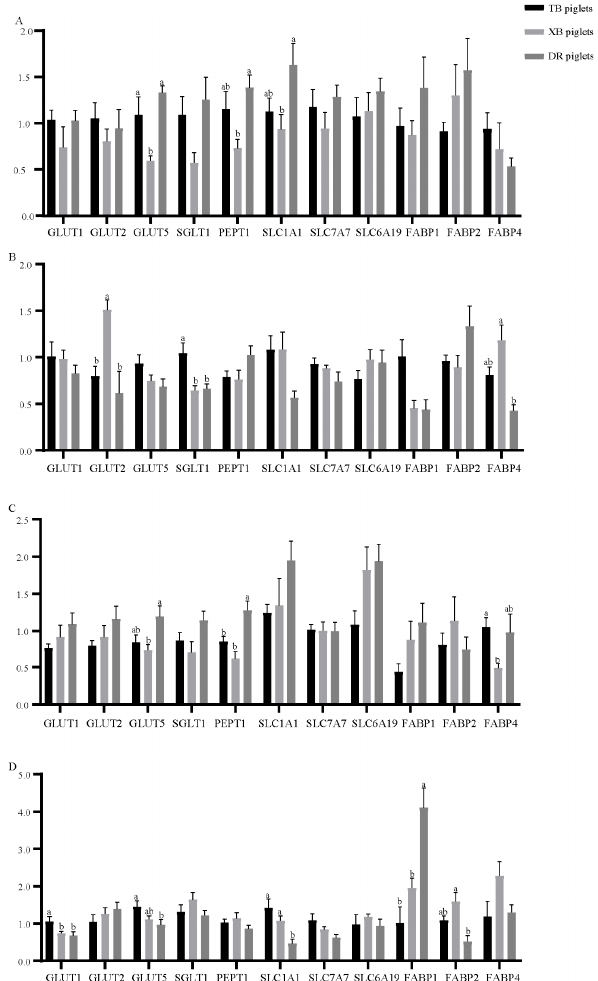
Figure 4. Differences in the ileal nutrient transporters of piglets at 1 day old ( A ), 10 days old ( B ), 21 days old ( C ), and 24 days old ( D ) ( n = 8). a,b Different letters indicate a significant difference ( p < 0.05). TB piglets, Taoyuan black piglets; XB piglets, Xiangcun black piglets; DR piglets, Duroc piglets. GLUT , glucose transporter; SGLT1 , sodium-glucose linked transporter 1; PEPT1 , peptide transporter 1; SLC1A1 , solute carrier family 1 member 1; SLC7A7 , solute carrier family 7 member 7; SLC6A19 , solute carrier family 6 member 19; SLC1A5 , solute carrier family 1 member 5; SLC7A9 , solute carrier family 7 member 9; FABP , fatty-acid-binding